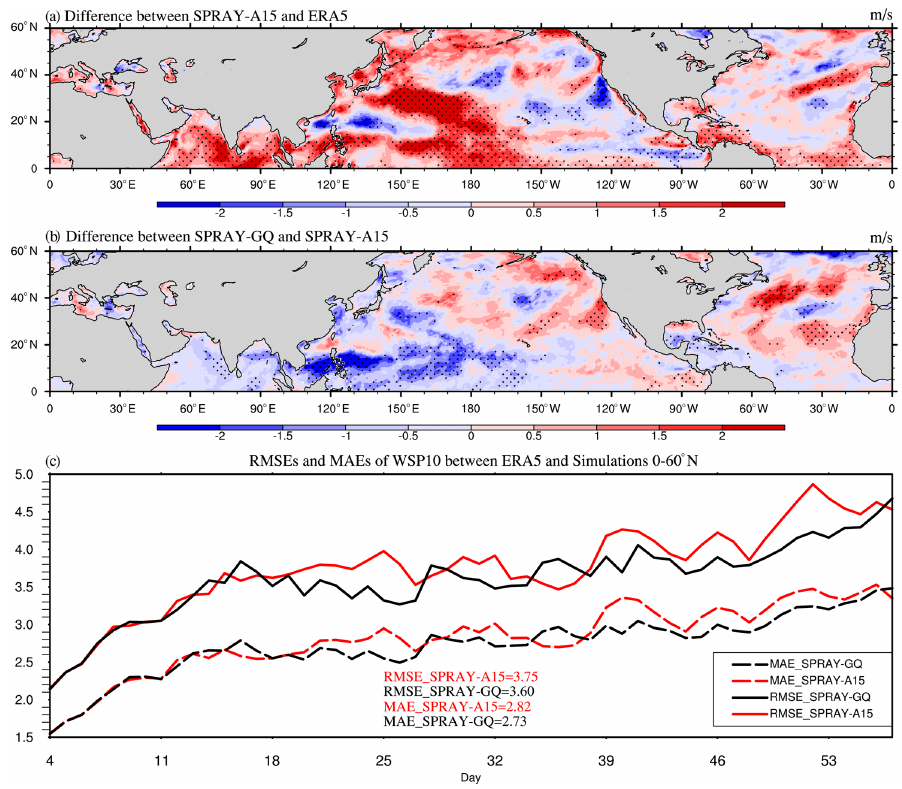
Figure 11. The same as Fig. 10, but for August–September